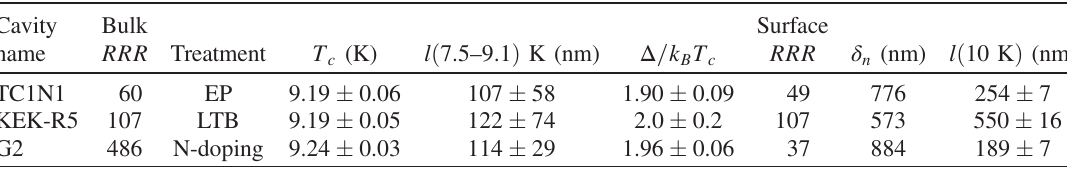
TABLE III. Material parameters T M-B theory. The surface RRR , skin depth, δ the surface resistance at 10